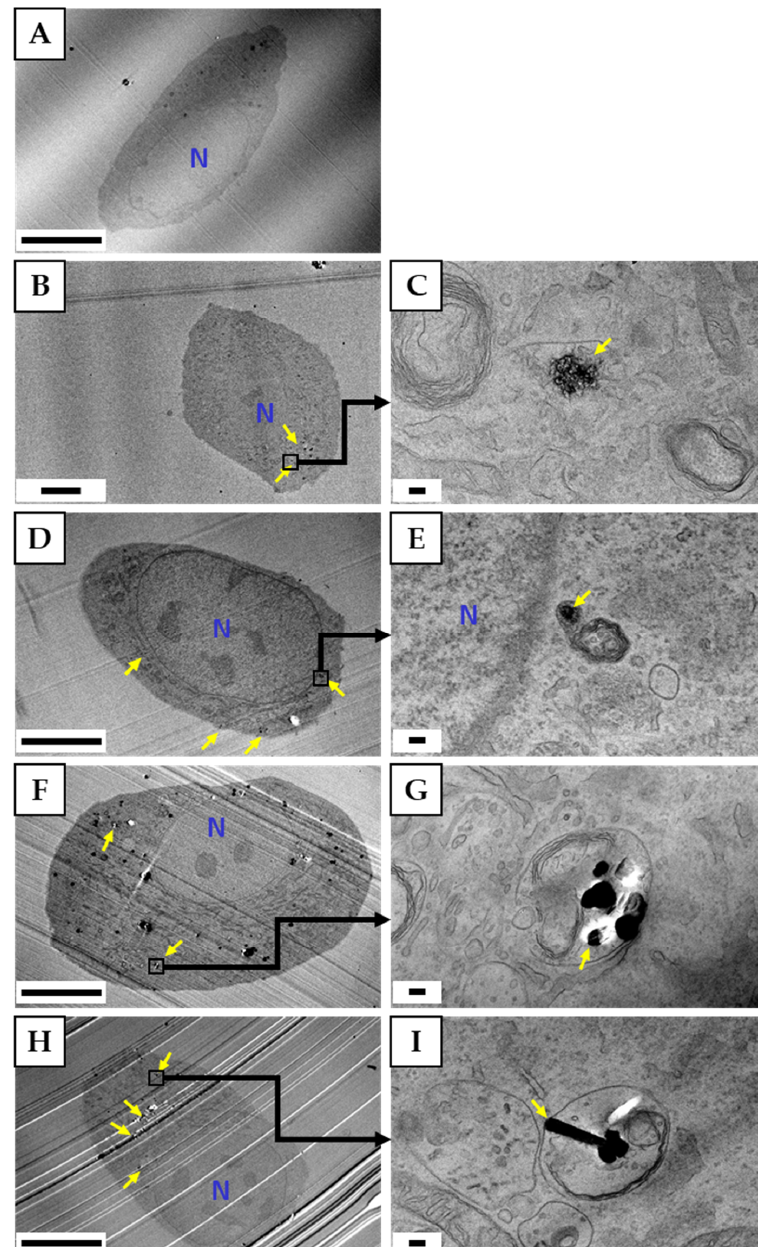
Figure 5. TEM images of HLECs exposed to CNMs at 10 µ g / mL. ( A ) Control, ( B , C ) unCNH, ( D , E ) oxCNH, ( F , G ) CB, ( H , I ) MWCNT. ( A , B , D , F , H ) Low magnification. Scale bars correspond to 10 µ m. ( C , E , G , I ) High magnification. Scale bars correspond to 100 nm. Yellow arrows indicate CNMs. TEM, transmission electron microscope; HLEC, human lymphatic endothelial cell; CNMs, carbon nanomaterials; unCNH, untreated carbon nanohorn; oxCNH, oxidized carbon nanohorn; CB, carbon black; MWCNT, multi-walled carbon nanotube; N,